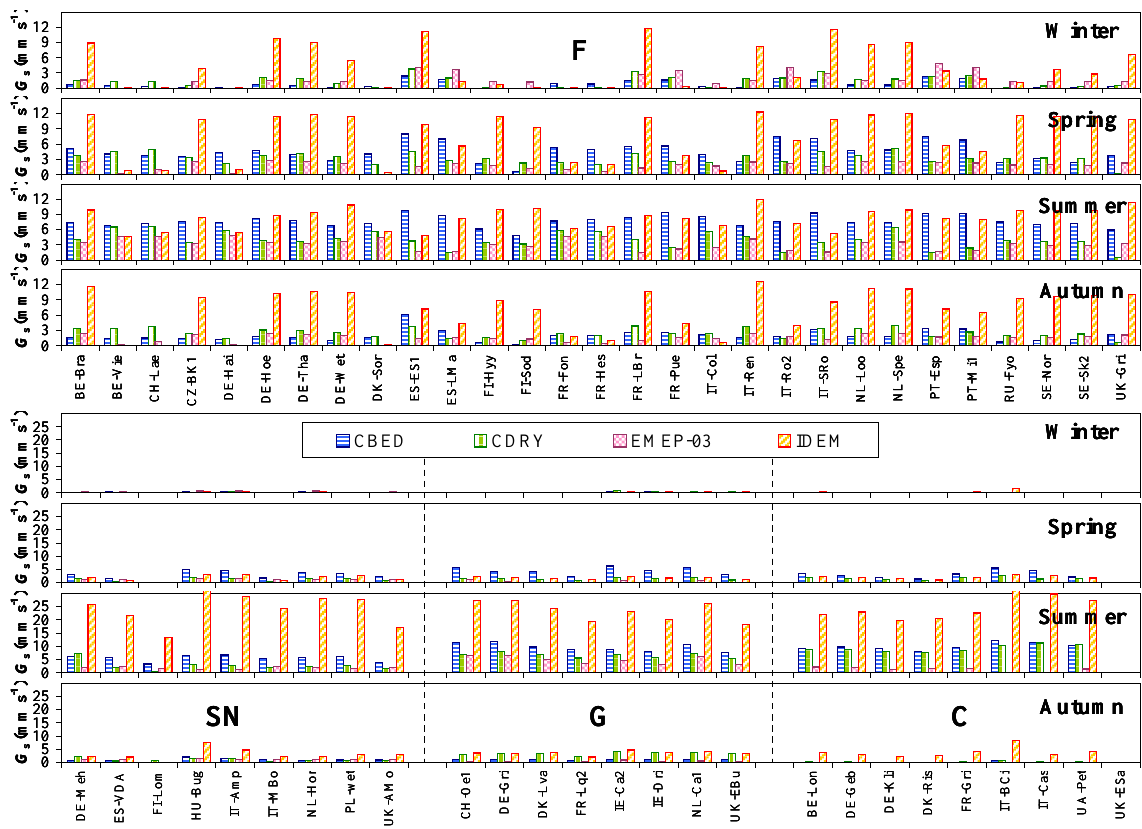
Figure 2. 2 Fig. 2. Comparison of mean modelled daytime bulk stomatal conductances from the four inferential schemes.